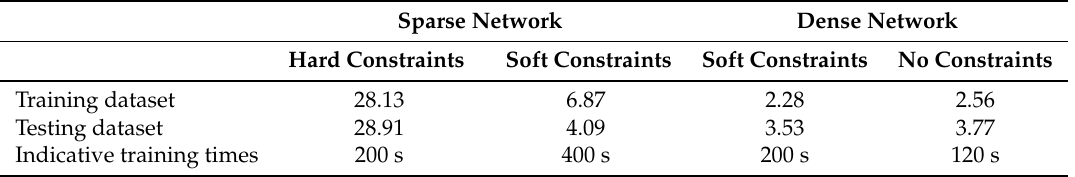
Table 1. Pricing RMSE (absolute pricing errors) and training times without Dupire